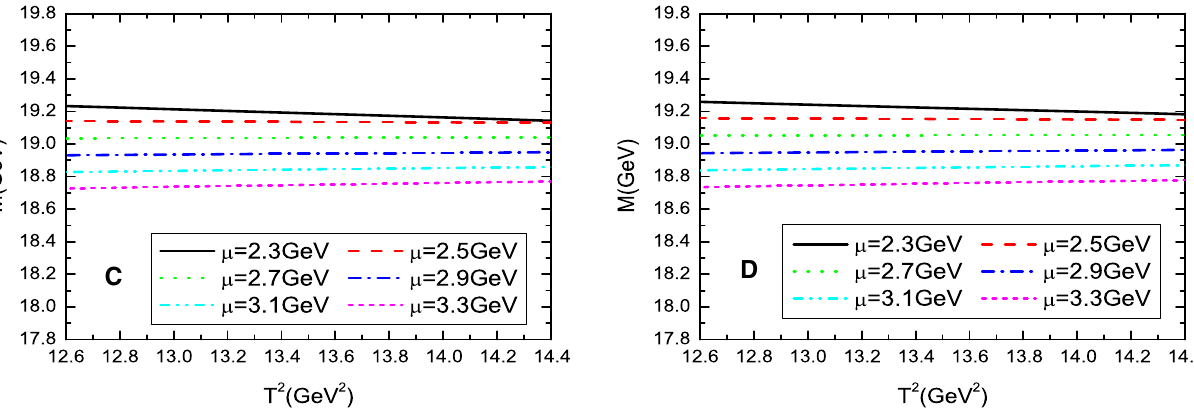
Fig. 2 Themassesofthe bb ¯ b ¯ b tetraquarkstateswithvariationsoftheenergyscalesandBorelparameters,wherethe C and D denotethe bb ¯ b ¯ b ( 0 ++ ) and bb ¯ b ¯ b ( 2 ++ ) ,